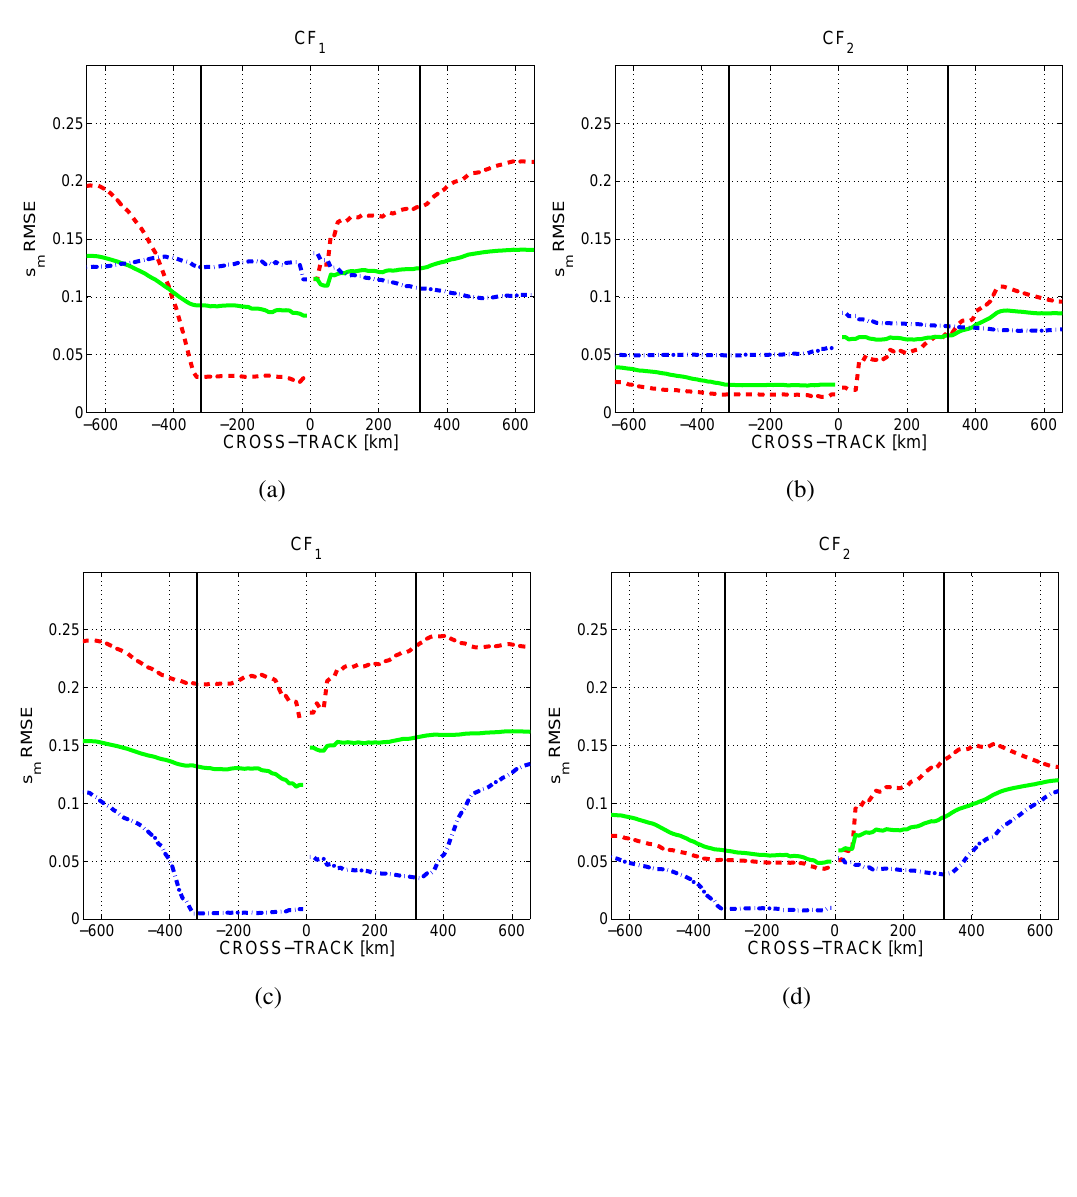
Figure 6. Retrieved soil moisture RMSE of simulated SMOS observations versus pixel position in the swath; Simulations over the dry (red, dashed lines), moist(green, solid lines), and wet (blue, dashed-dotted lines) scenarios of Table 1. First row: bare soil scenarios, second row: vegetation-covered scenarios. Left column: with no constraints on the cost function ( CF column: adding constraints on all parameters, except s first Stokes parameter (left side) and Earth reference frame (right side). Vertical lines denote the Narrow